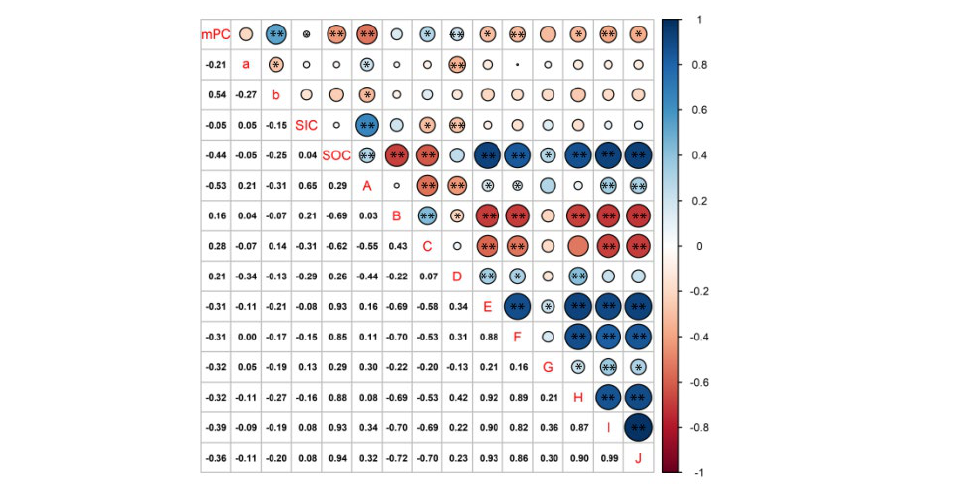
Figure 6. Two-dimensional ranking diagram and correlation coefficient matrix of soil SOC to SIC change. a: δ 13 C-SIC; b: δ 13 C-CO 2 ; A: soil water content; B: soil bulk weight; C: pH; D: total salt; E: total nitrogen; F: effective phosphorus; G: fast-acting potassium; H: readily available carbon; I: water-soluble carbon; J: microbial biomass carbon. Note: ** indicates highly significant correlation ( p < 0.01), * indicates significant correlation ( p < 0.05). Table 1. Significance ranking and significance test results for the explanation of physical and chem- ical environmental variables.